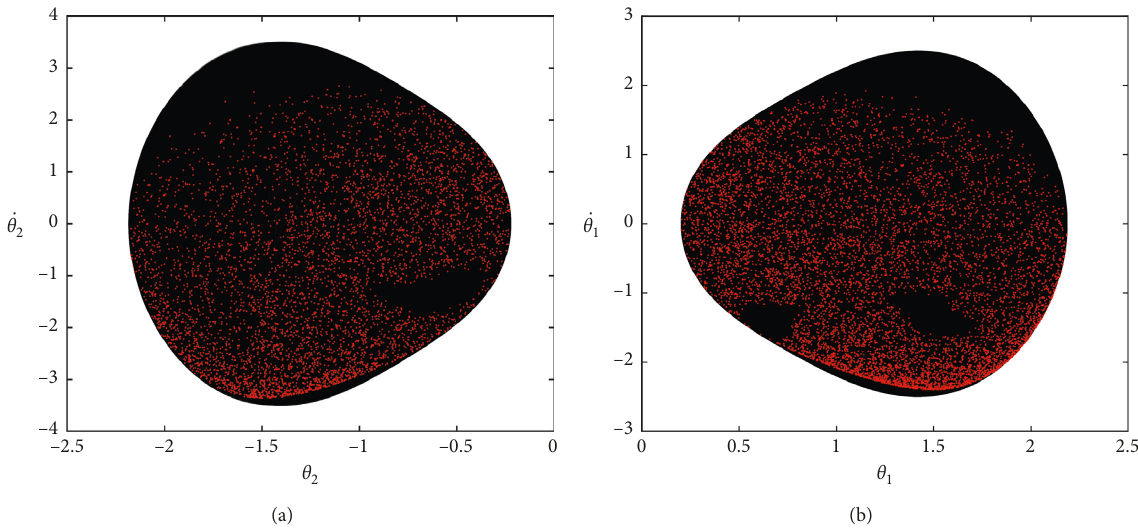
Figure 7: Phase planes (in black) and Poincar´e map (in red) for nonideal loaded manipulator. (a) Poincar´e section of θ section of θ 2